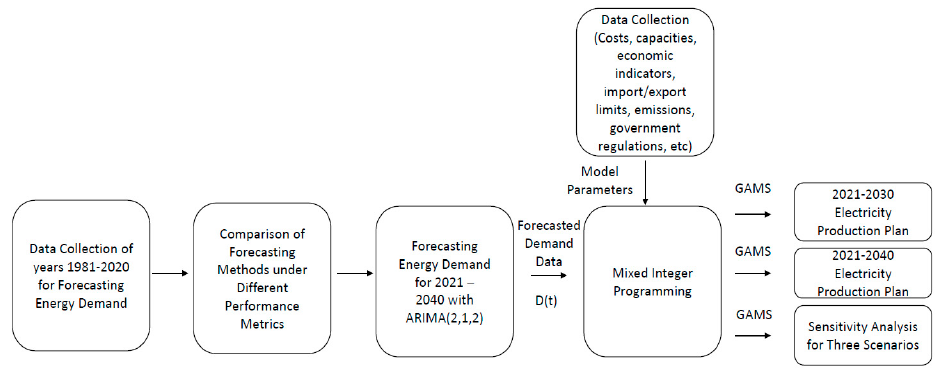
Figure 1. Framework of the Proposed Methodology.